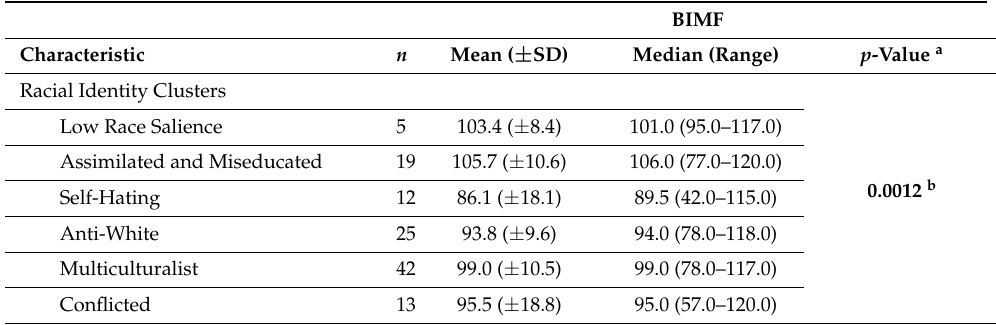
Table 2. Bivariate analyses to assess associations between characteristics of Black postpartum mothers living in Georgia and maternal functioning.